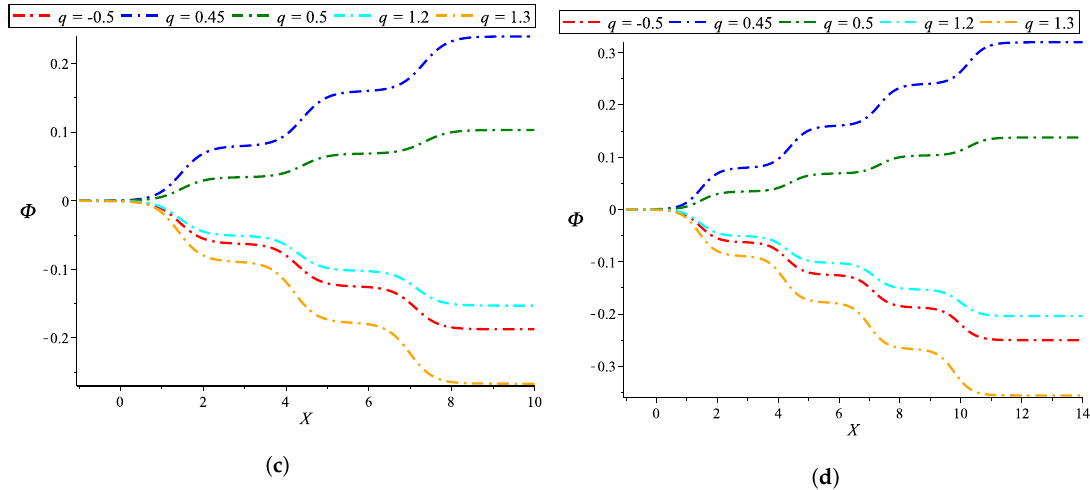
Figure 5. Effect of q on the electrostatic ( a ) single-, ( b ) overtaking collision of double-, ( c ) overtaking collision of triple-, and ( d ) overtaking collision of four-shock wave excitations, respectively, by choosing α = 0.3, M r = 3.75, T ni = 0.05, T e = 0.2, N r 1 = 0.5, N r 2 = 0.02, µ ni = 0.01, and µ pi = 0.5.